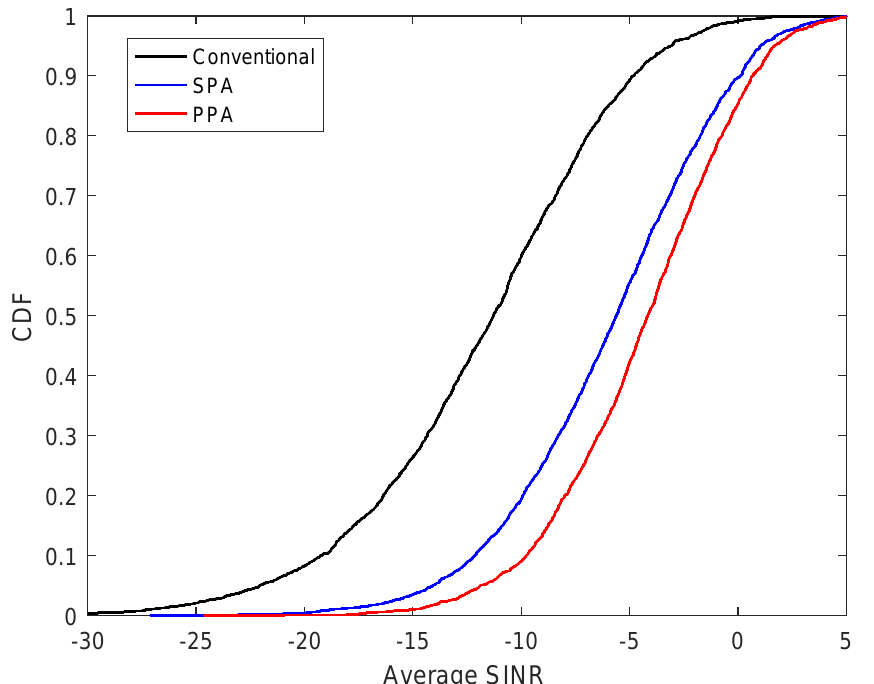
Figure 9. CDF of the average SINR per user when M = 64 using an MRC detector.